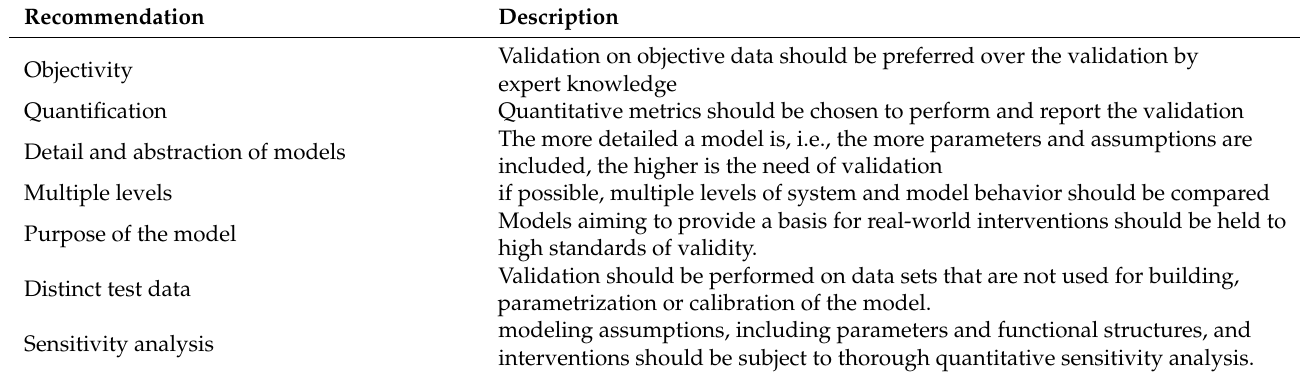
Table 4. Recommendations for the validation of agent-based